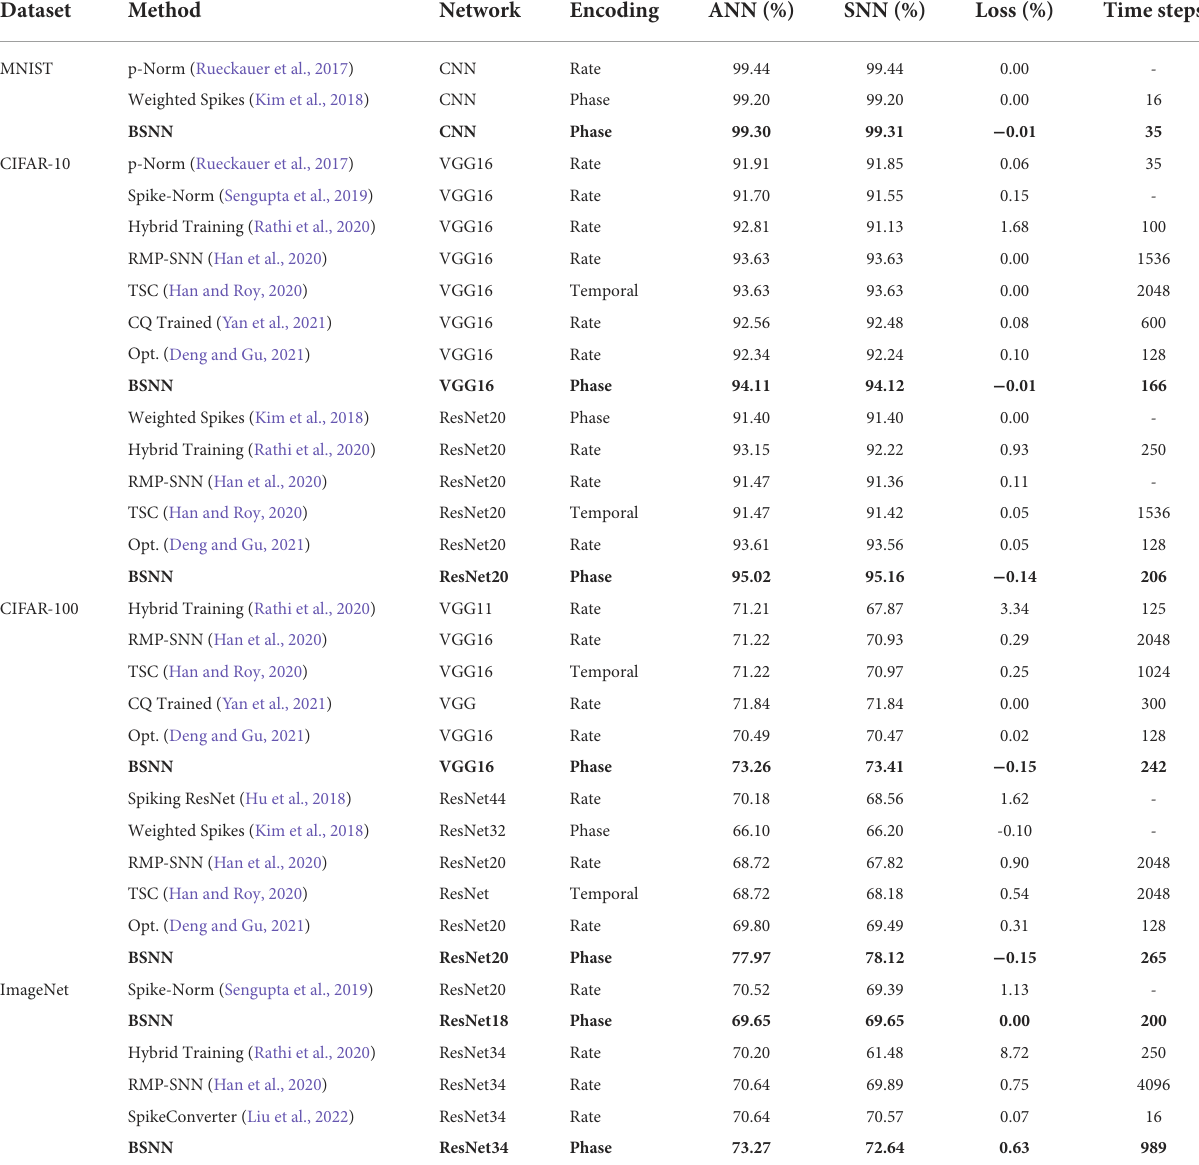
TABLE 1 Top-1 classification accuracy on MNIST, CIFAR-10, CIFAR-100, and ImageNet for our converted SNNs, compared to the original ANNs, and compared to other conversion methods.